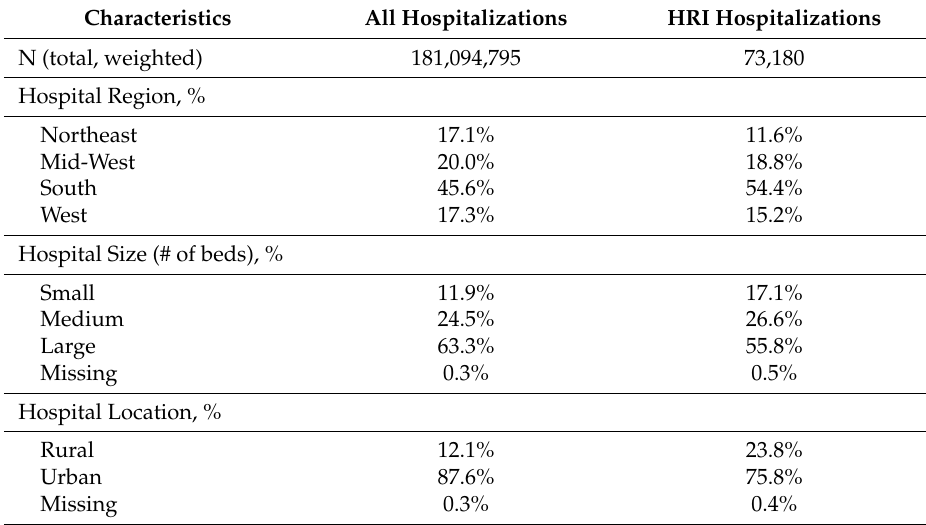
Table 2. Hospital characteristics of patients hospitalized with and without a heat-related illness